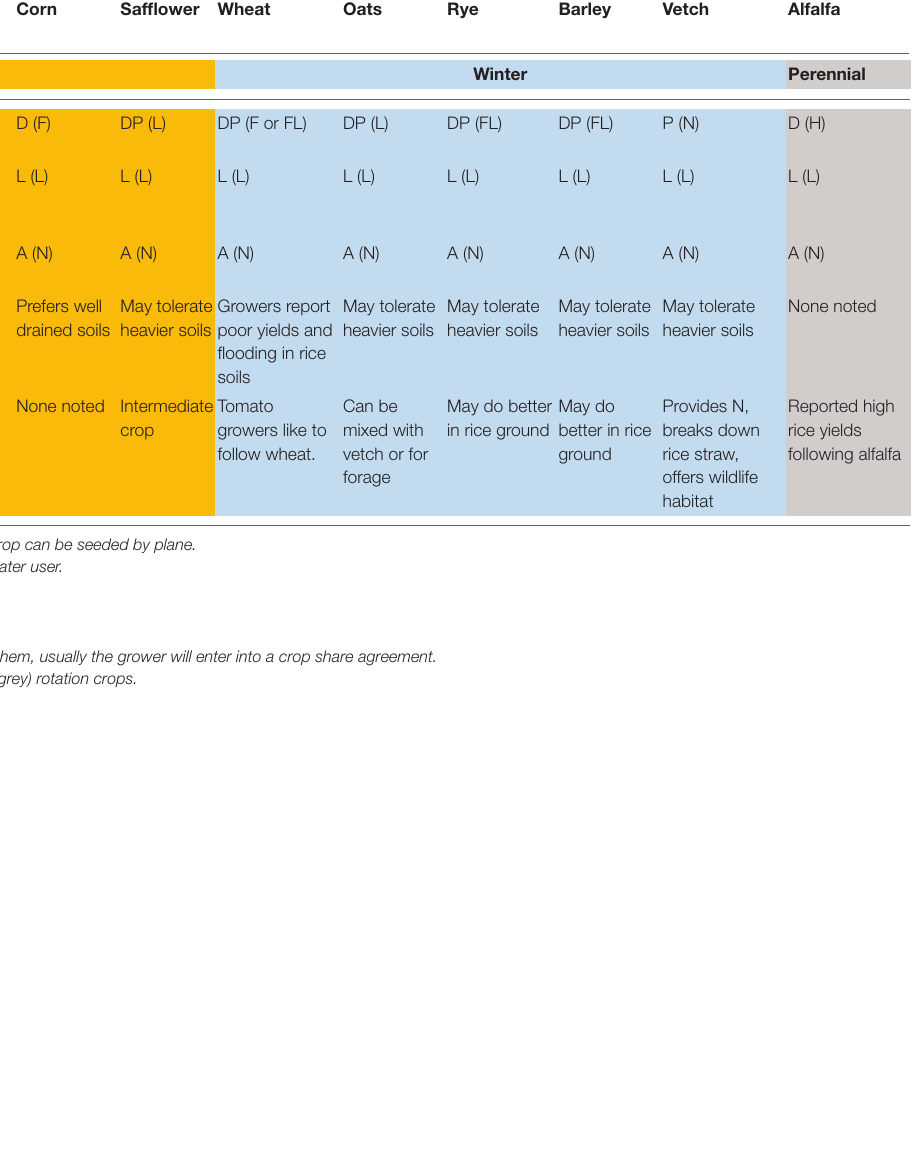
TABLE 2 | Summary of grower interviews for common rotation crops comparing perceived profitability level, production costs, markets, soil tolerance, equipment, water usage, and rotation benefits. Tomato Sunflower Vine seed Cucurbits Beans Corn Safflower Wheat Oats Rye (summer)